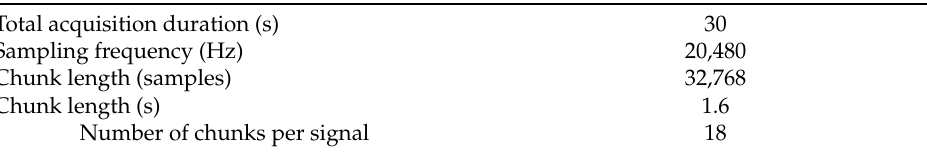
Table 5. Signal extraction.